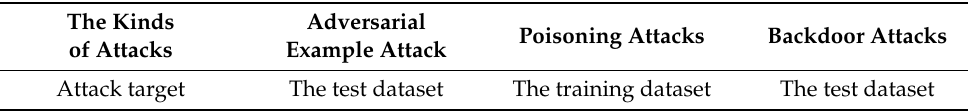
Table 1. Summary for the attack on ML